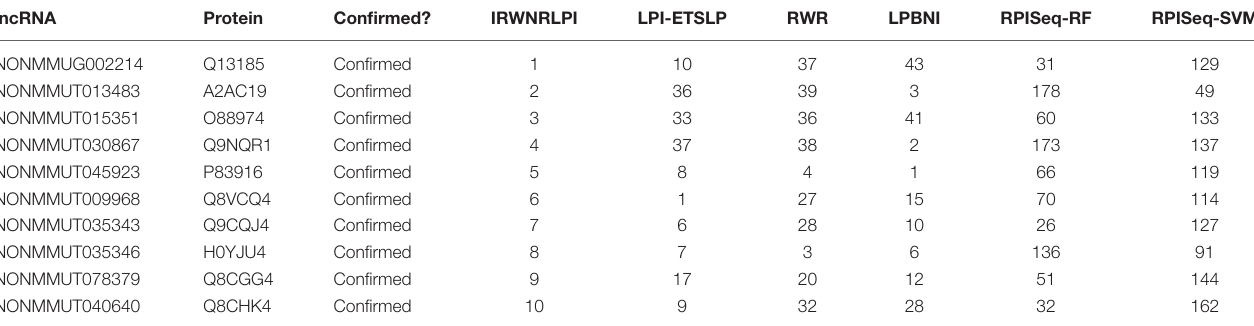
TABLE 2 | Top 10 novel interactions predicted by IRWNRLPI and their ranks in the prediction of other methods. lncRNA Protein Confirmed?